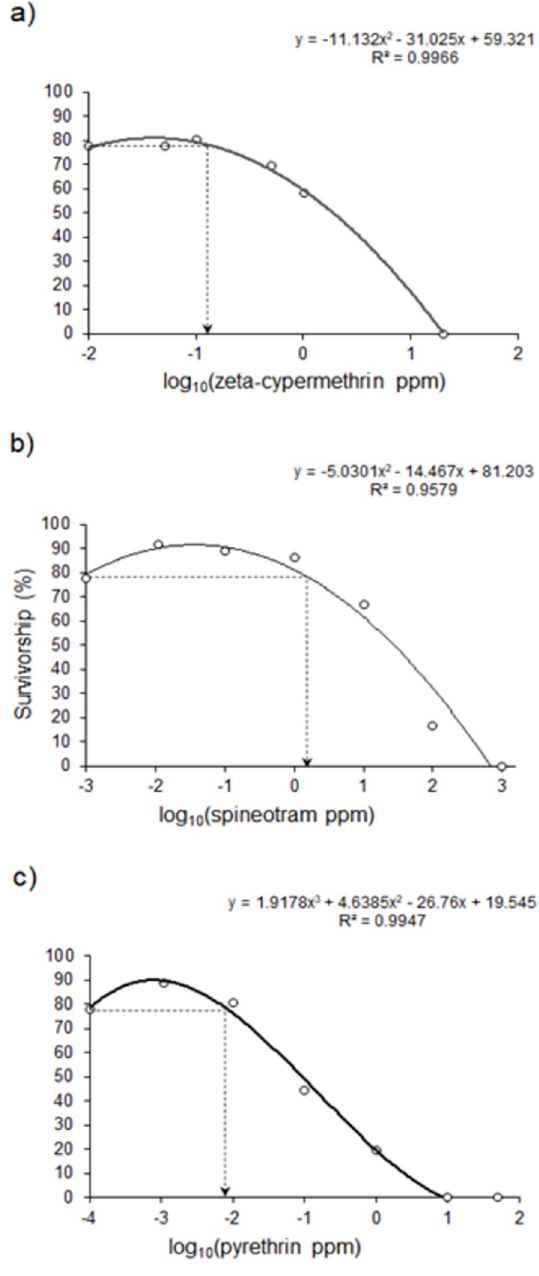
Fig 1. Initial dose-response curves. Initial dose-response curves and equations for zeta-cypermethrin (a), spinetoram (b), and pyrethrin (c) with the dotted lines representing the zero equivalent point. Log transformations for zeta- cypermethrin and spinetoram were log10(ppm + 0.001) and log10(ppm + 0.0001) for pyrethrin. https://doi.org/10.1371/journal.pone.0271417.g001 Table 2. Concentrations tested for each insecticide treatment and their corresponding lethal concentrations. Confidence intervals (95%) are shown in parentheses.